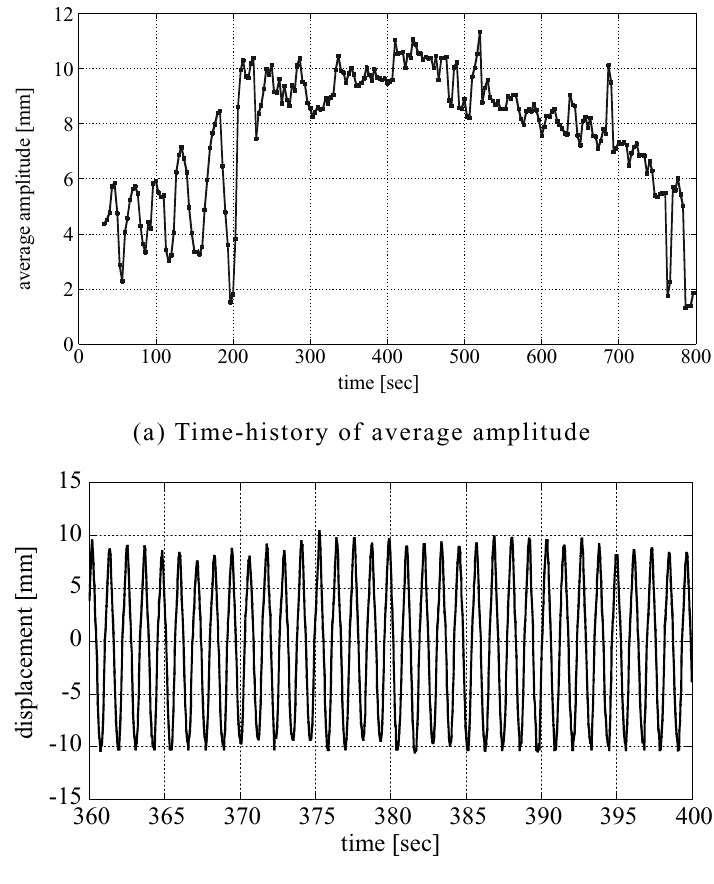
Fig. 11. Lateral vibration of the bridge deck obtained by the image